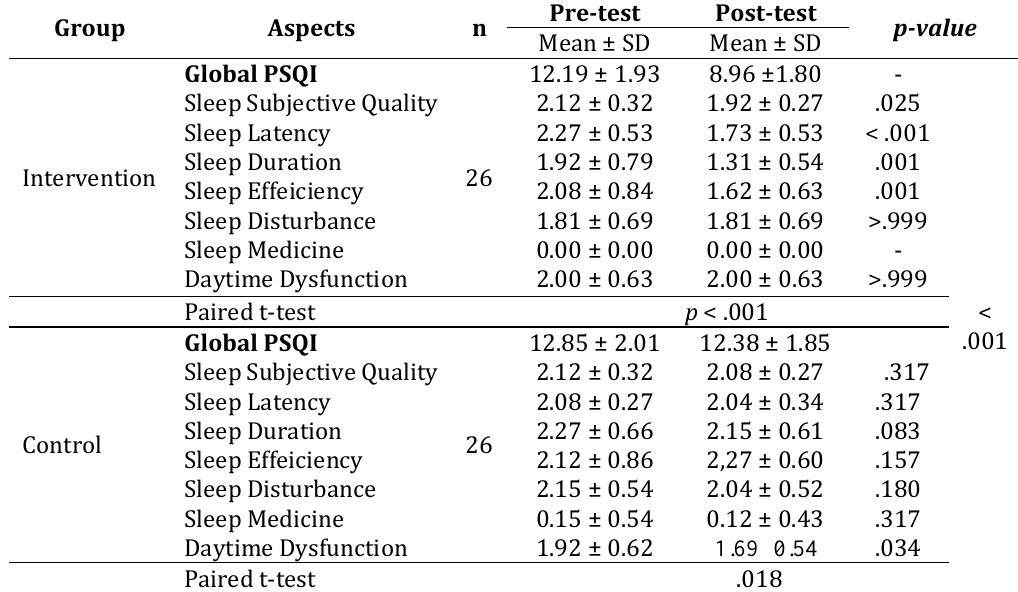
The distribution of sleep quality (pretest and posttest) (n=52)